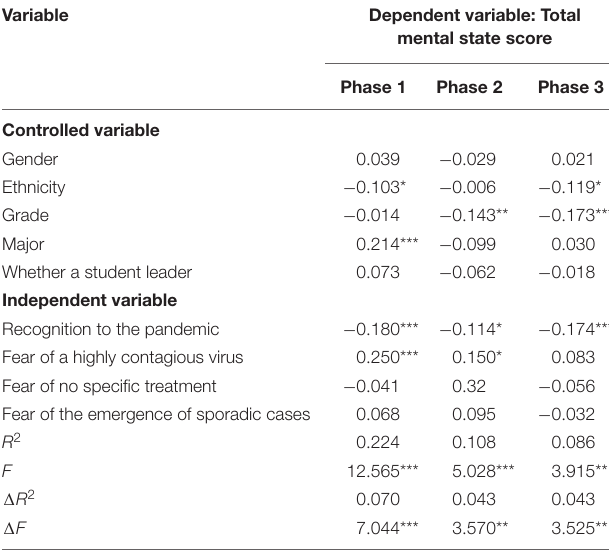
TABLE 4 | Hierarchical multiple regression analysis of influencing factors of college students’ psychological